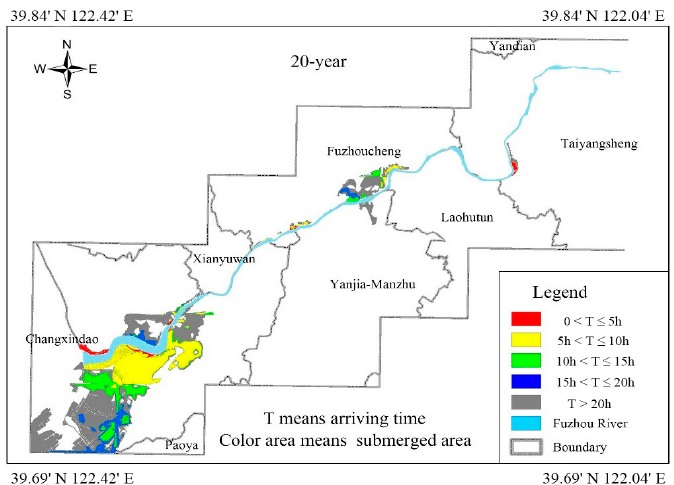
Figure 8. Flood arrival time and submerged area of 20-year return period scenario.